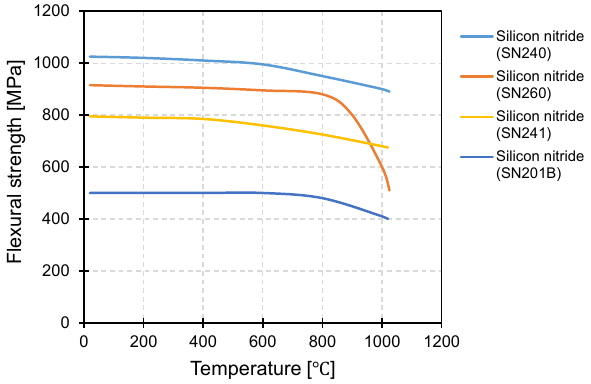
Figure 10: Flexural strength vs. temperature for different types of silicon nitride produced by Kyocera (based on [30])